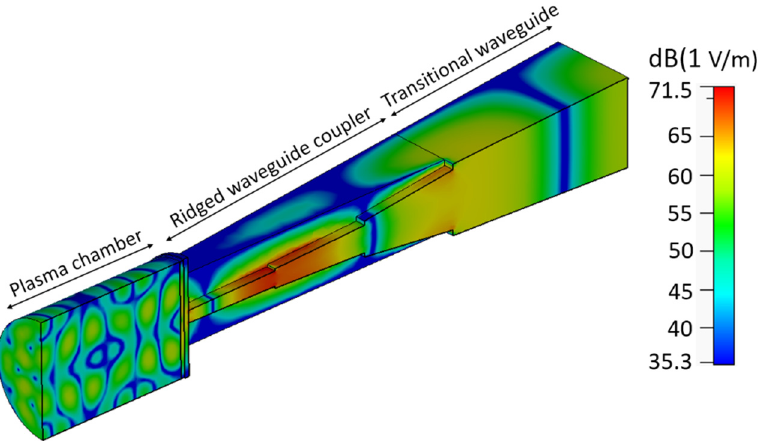
Figure 7. Simulated electric field distribution with 1 W input power through a TE 10 mode port.